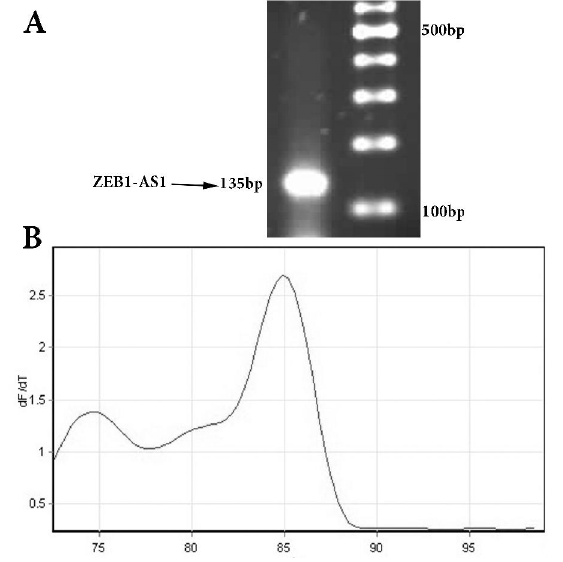
Fig. 1. The specific primers used for the proliferation fragment of ZEB1-AS1: (A) single-band of PCR product on 2% agarose gel which was stained with ethidium bromide; (B) Melting curve analysis of ZEB1-AS1 in RT-qPCR